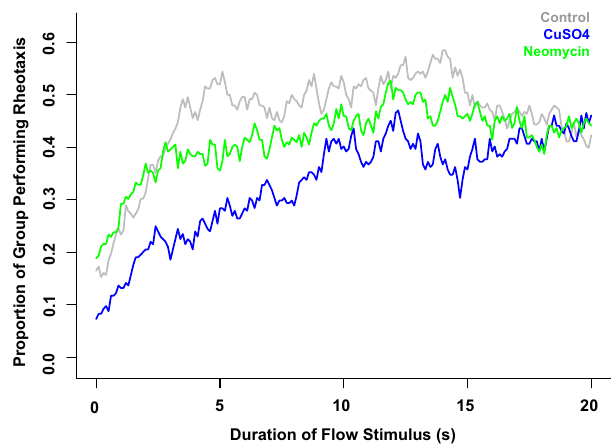
Fig. 6 Intact lateral line enabled a greater proportion of fi sh to perform rheotaxis within the fi rst 15 seconds of stimulus onset. Time series of the proportion of individual fi sh within each group that performed rheotaxis during fl ow presentation. A greater proportion of lateral line intact fi sh (gray = control, n = 248 fi sh) performed rheotaxis than lesioned fi sh (blue = CuSO 4 , n = 204 fi sh; green = neomycin, n = 222 fi sh; 18 experimental sessions). The data for all treatments converges after 17 s of fl ow were of relatively small magnitude in controls and CuSO 4 -treated fi sh, and relatively large magnitude in neomycin-treated fi sh